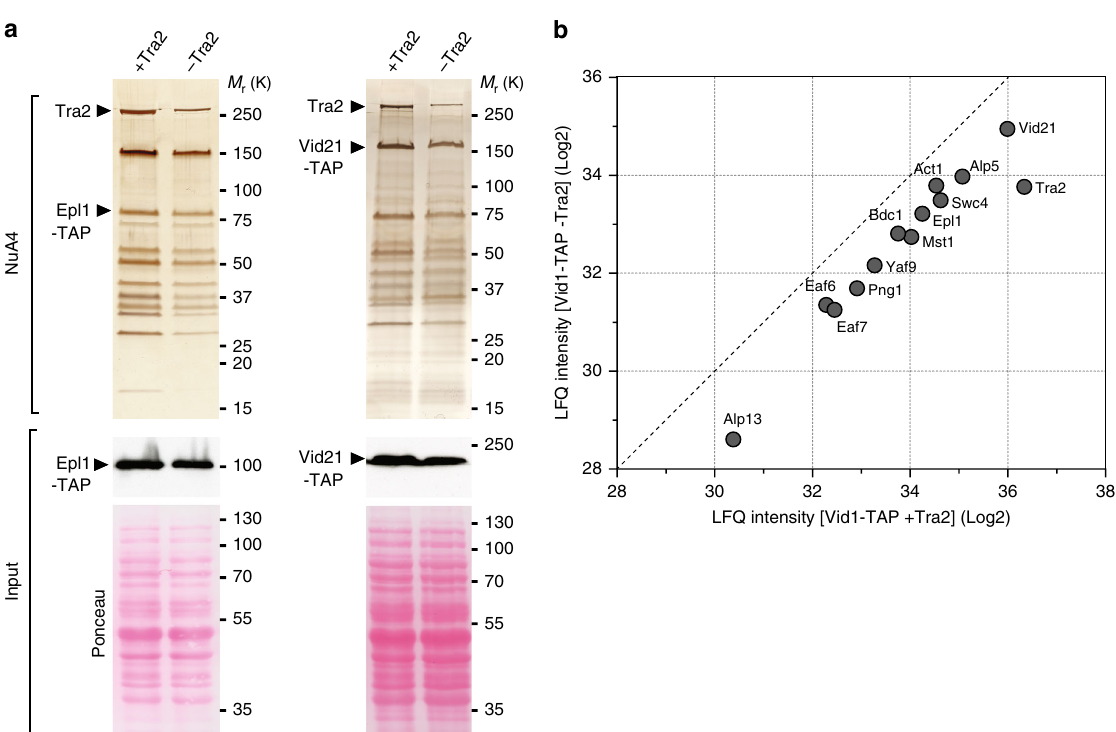
Fig. 4 Tra2 is important for the formation of the entire NuA4 complex. a Silver staining of NuA4 complexes puri fi ed either in the presence or absence of Tra2, using Epl1-TAP (left) and Vid21-TAP (right) as baits. Cells were grown to exponential phase in rich medium supplemented with either DMSO ( + Tra2) or β -estradiol (-Tra2), for either 16 h ( epl1-TAP tra2-CKO ) or 21 h ( vid21-TAP tra2-CKO ). Below are anti-HA western blotting of Epl1-TAP (left) and Vid21-TAP (right) from a fraction of the input used for TAP. Ponceau red staining is used as control for equal protein content and loading. b Scatter plot representing the LFQ intensities from LC-MS/MS analysis of NuA4 complexes puri fi ed in the presence ( x -axis) or absence ( y -axis) of Tra2. Individual points represent individual NuA4 subunits in Vid21-TAP eluates. The dashed line shows a 1:1 ratio. Data are representative of two independent experiments. Source data are provided as a Source Data fi